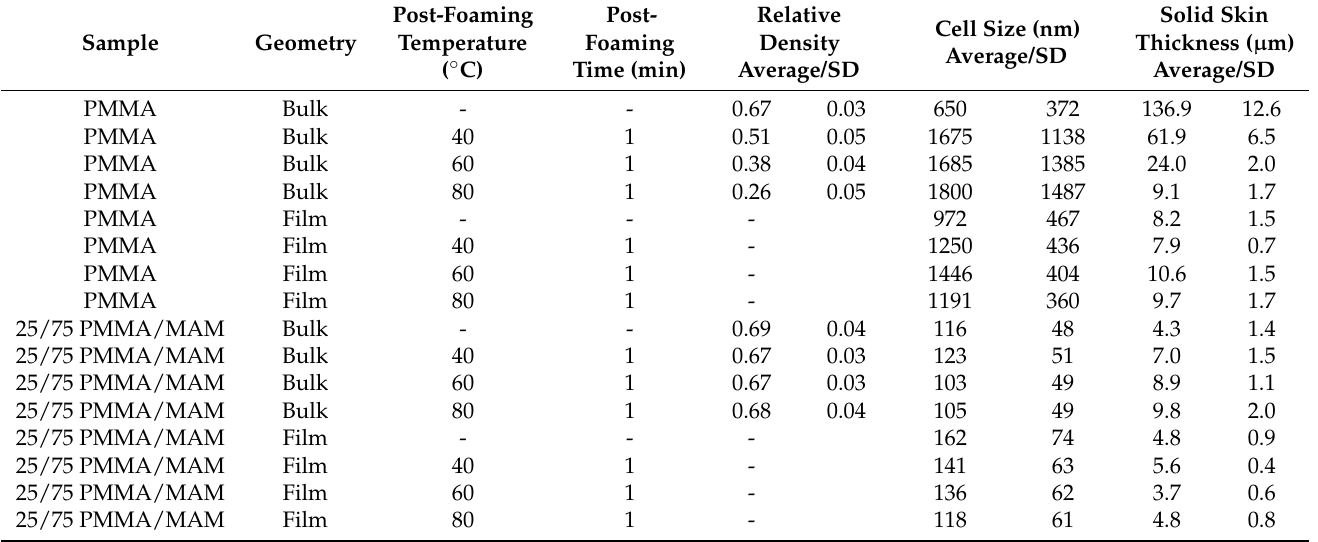
Table 2. Main characteristics of the neat PMMA and 25/75 PMMA foams obtained in a two-step foaming process. Histograms of the cell size distribution of each sample can be found in Figure S9, see Supplementary